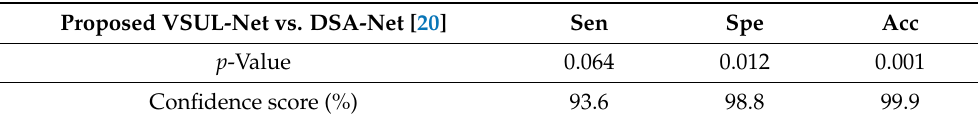
The t -test performance difference analysis ( p -value and confidence score) for the STARE